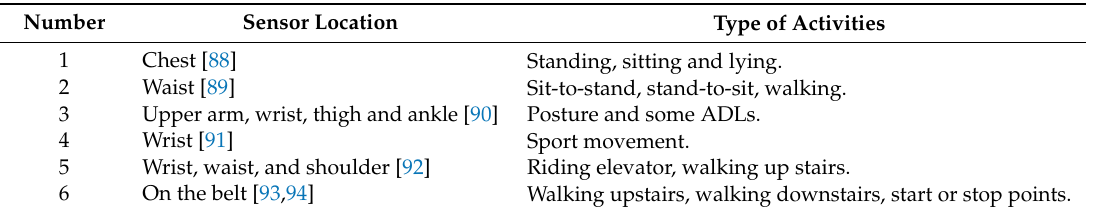
Table 4. Body sensor